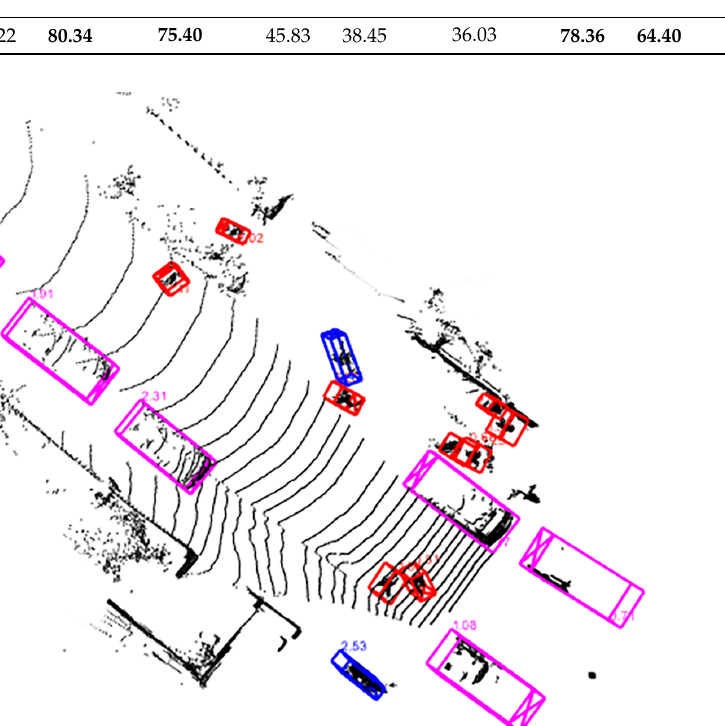
Figure 7. Qualitative results on the KITTI dataset. The pink, blue and red boxes represent cars, cyclists and pedestrians,